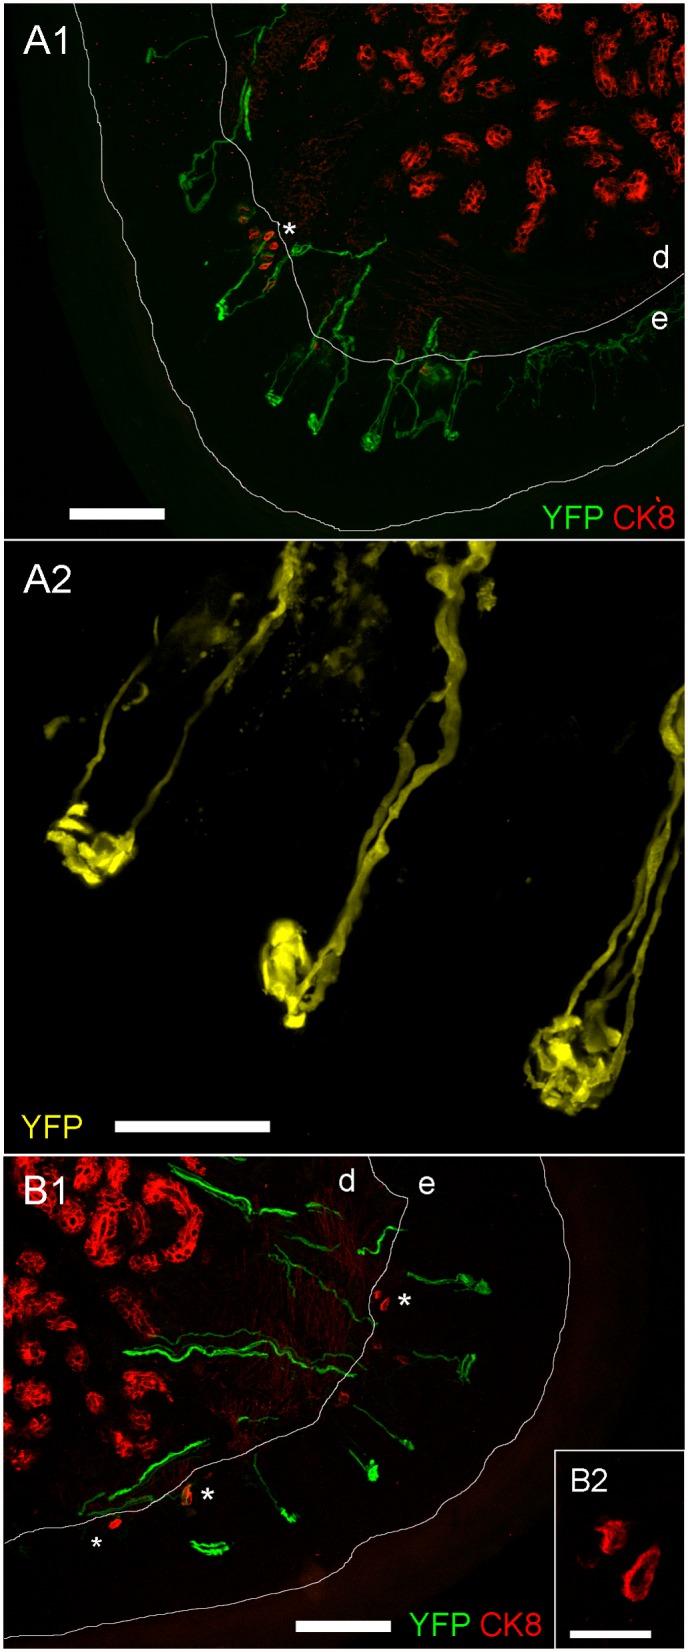
Confocal imaging of YFP expression in glabrous skin nerve terminals of the hind paw.
A1 and B1, multiple YFP-expressing sensory terminals within the epidermis (e). CK8-positive Merkel cells (denoted by *) are located at the basal epidermal layer. Other CK8-positive cells are found within the dermis (d). YFP is shown in green and CK8 is shown in red, scale bar represents 100 μm. A2, fine structure of YFP-expressing sensory terminals within the epidermis. YFP is shown in yellow, scale bar represents 25 μm. B2, fine structure of CK8-positive Merkel cells, scale bar represents 20 μm.